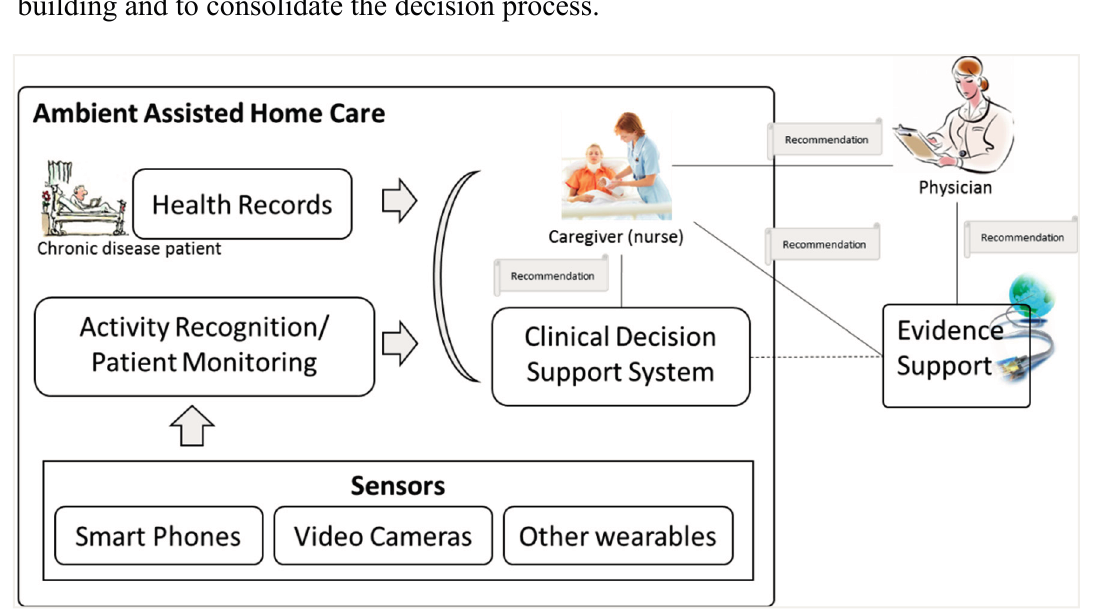
Figure 1. Evidence supported CDSS recommendation service for chronic disease patients in ambient assisted home care